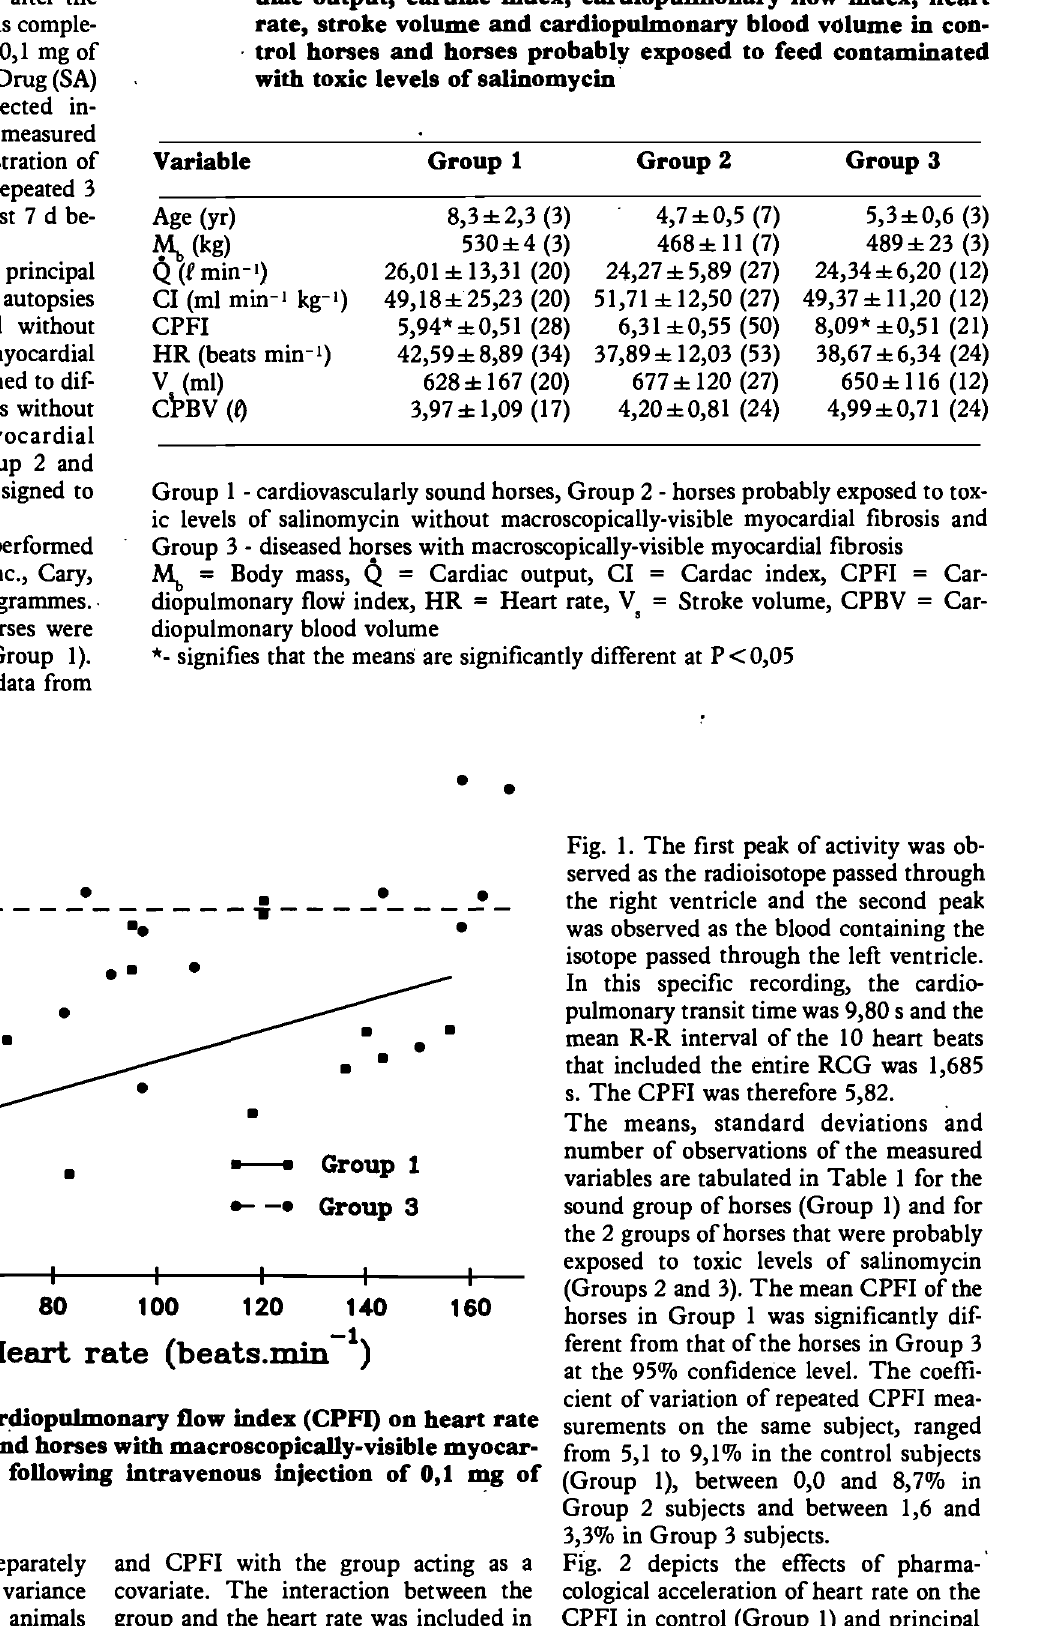
Fig. 2: Linear regressiqn of cardiopulmonary flow index (CPFI) on heart rate for controls (Group 1) and horses with macroscopically-visible